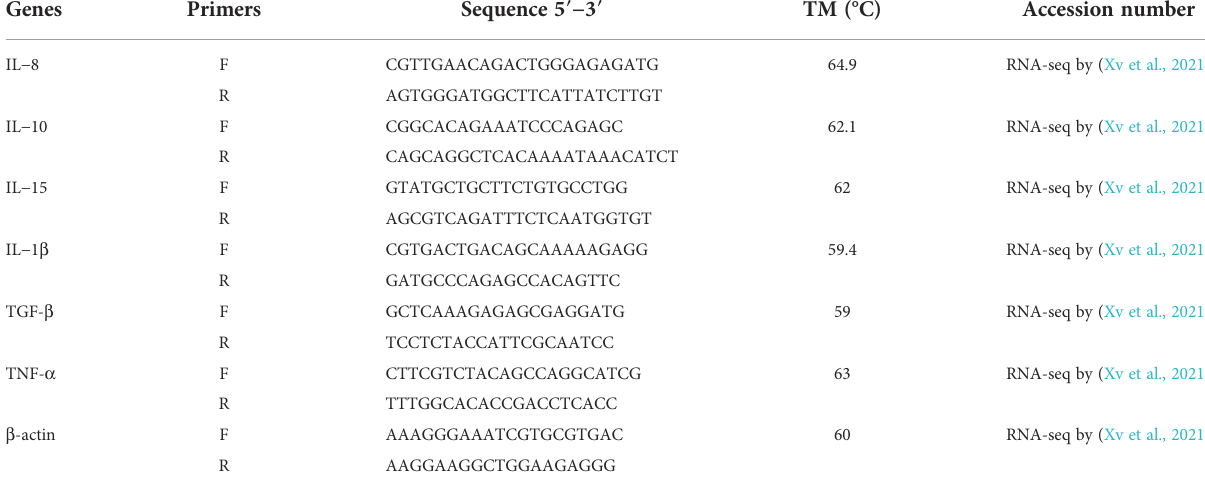
TABLE 3 Primer sequences for real-time